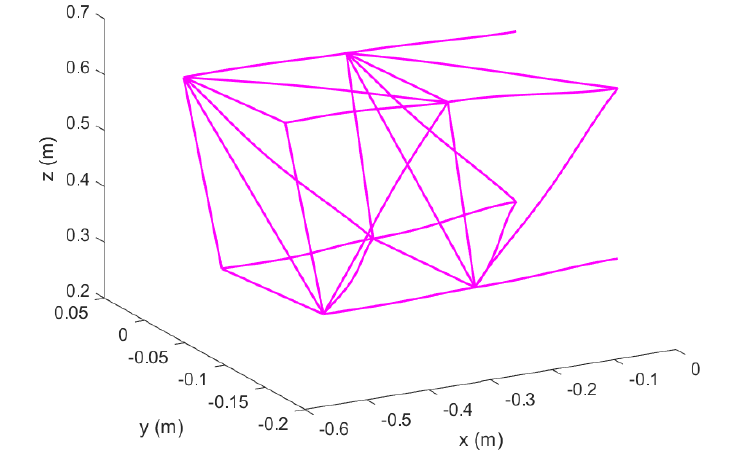
Figure 12. Mode 2 of Euler–Bernoulli Beams in Topology 1 with no hinged ends; original configuration.